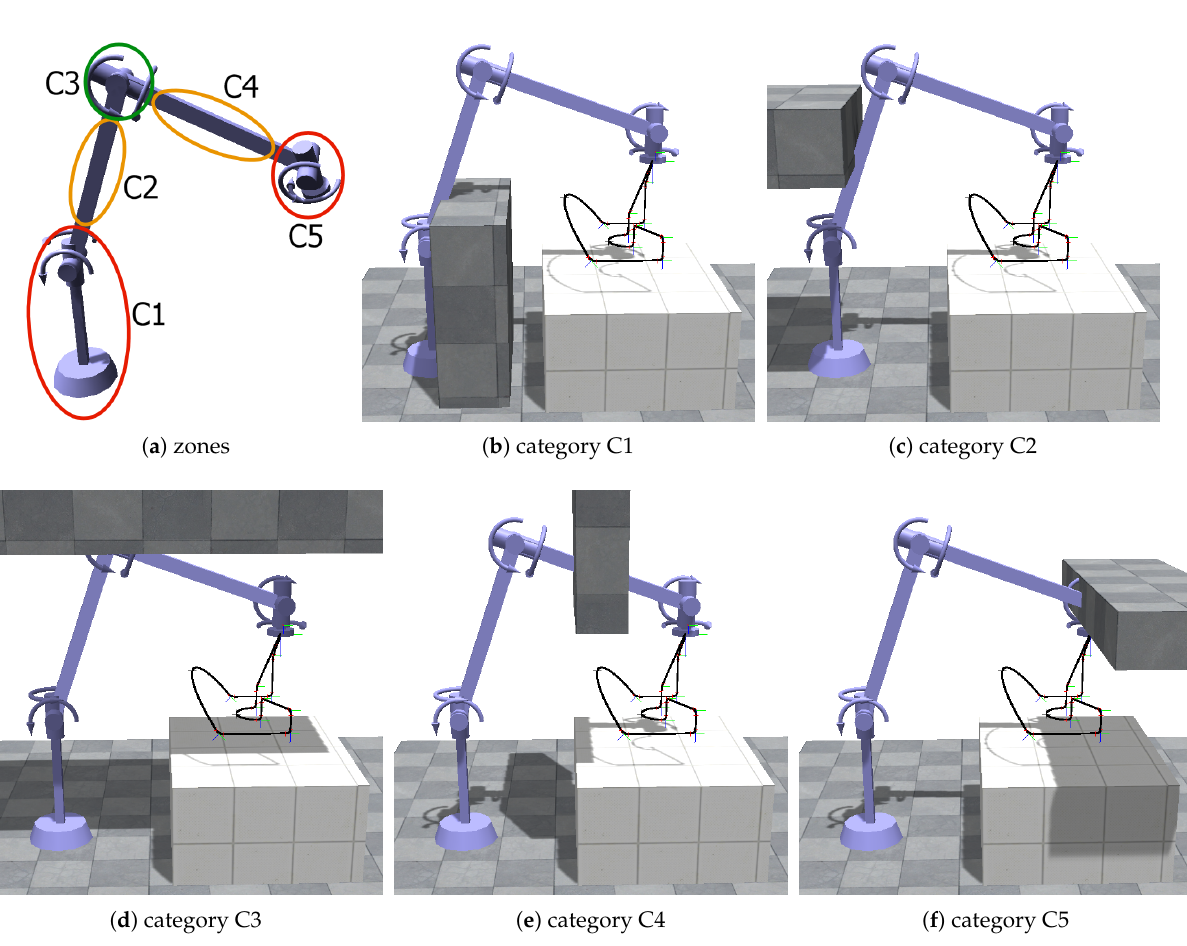
Figure 6. Simplified representation of the robot’s kinematic structure with zones corresponding to the collision categories, and examples of categories